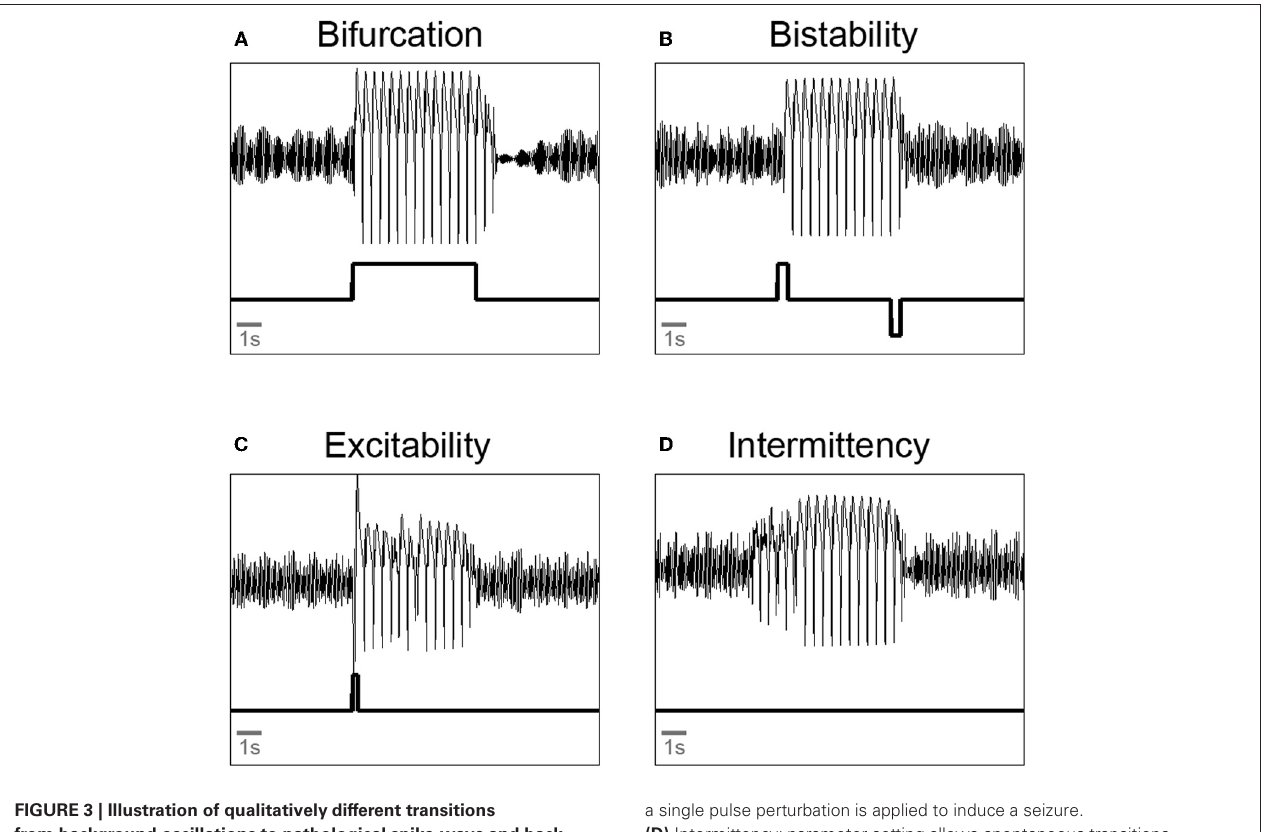
a single pulse perturbation is applied to induce a seizure. (D) Intermittency: parameter setting allows spontaneous transitions into and out of the seizure rhythms. All simulations done with a three compartment version of the extended Jansen-Rit model (Goodfellow et al., 2011). Upper trace: model output. Lower trace: parameter